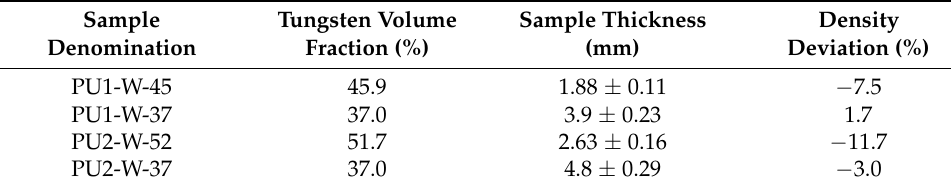
Table 8. Samples of tungsten-powder-loaded polyurethane